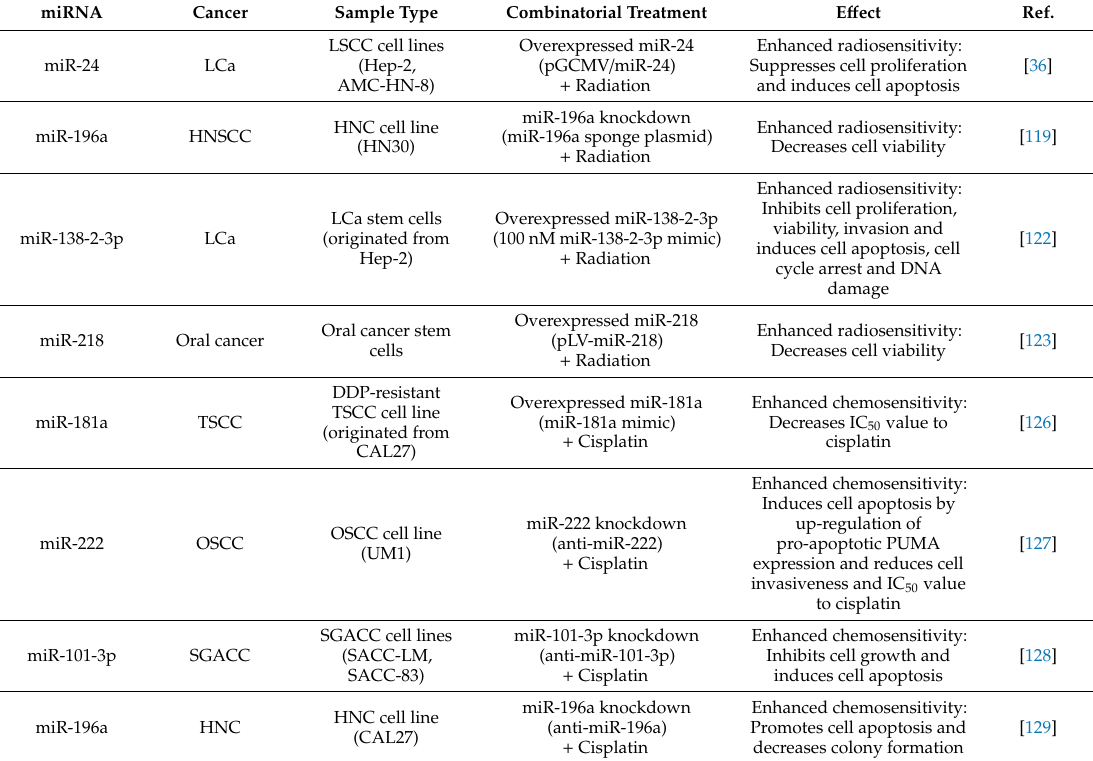
Table 3. Combinatorial studies between miRNAs and chemio /